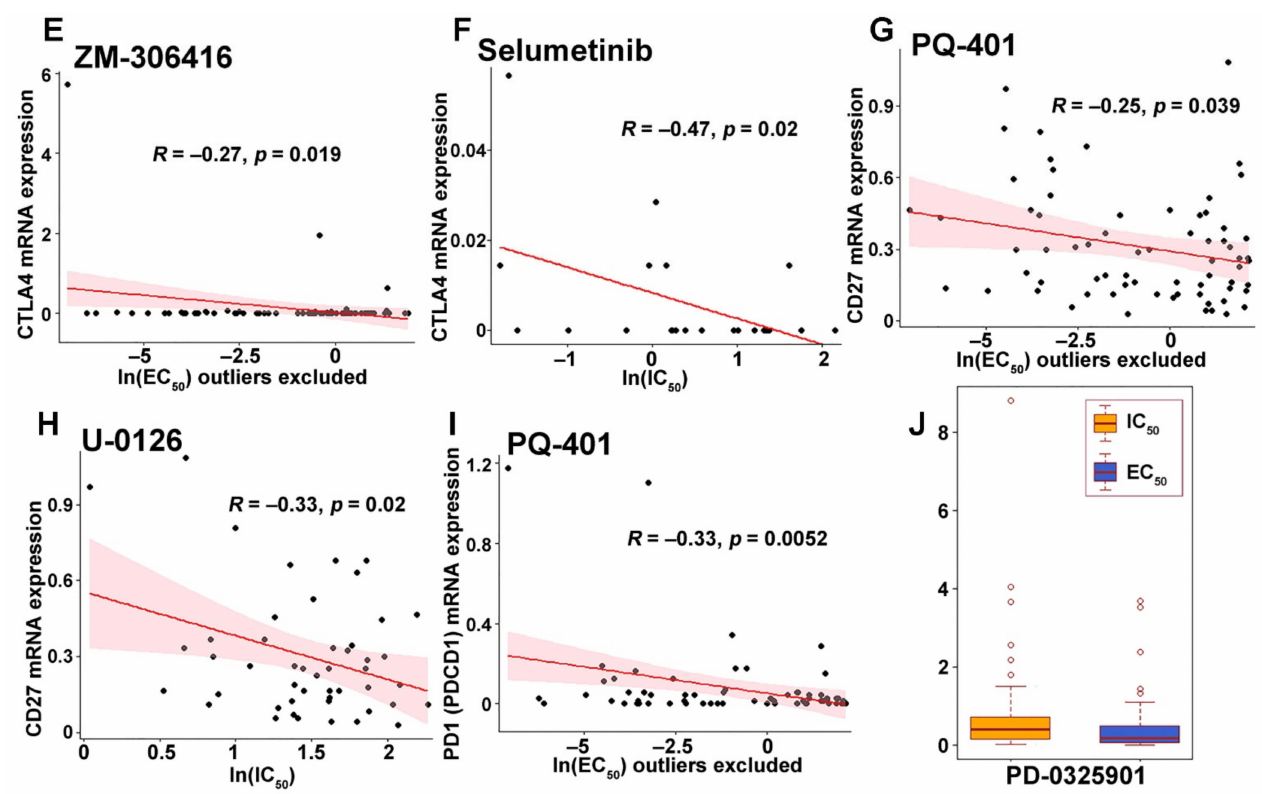
Figure 8. Discovering repositioning drugs based on the selected genes: Selection of significant func- tional pathways and repositioning drugs based on the selected genes ( A ). The Pearson correlations of PDL1 (CD274) protein expression with AS-703026 EC 50 excluding outliers ( B ), CTLA4 mRNA expression with PD-198306 IC 50 excluding outliers ( C ), PD-198306 ln(IC 50 ) excluding outliers ( D ), ZM-306416 ln(EC 50 ) excluding outliers ( E ), and selumetinib ln(IC 50 ) ( F ), CD27 mRNA expression with PQ-401 ln(EC 50 ) excluding outliers ( G ) and U-0126 ln(IC 50 ) ( H ), PD1 ( PDCD1 ) mRNA expression with PQ-401 ln(EC 50 ) excluding outliers ( I ). Selected compounds that had a low average IC 50 and EC 50 in the CCLE NSCLC cell lines ( n = 64 [IC 50 ]; n = 88 [EC 50 ]) ( J ). To investigate if the identified compounds can effectively inhibit the growth of NSCLC cells, the average IC 50 and EC 50 values in the CCLE NSCLC cell lines ( n = 135) of the drugs available in PRISM were examined (Table 3). PD-0325901 (Figure 8J) and dasatinib had